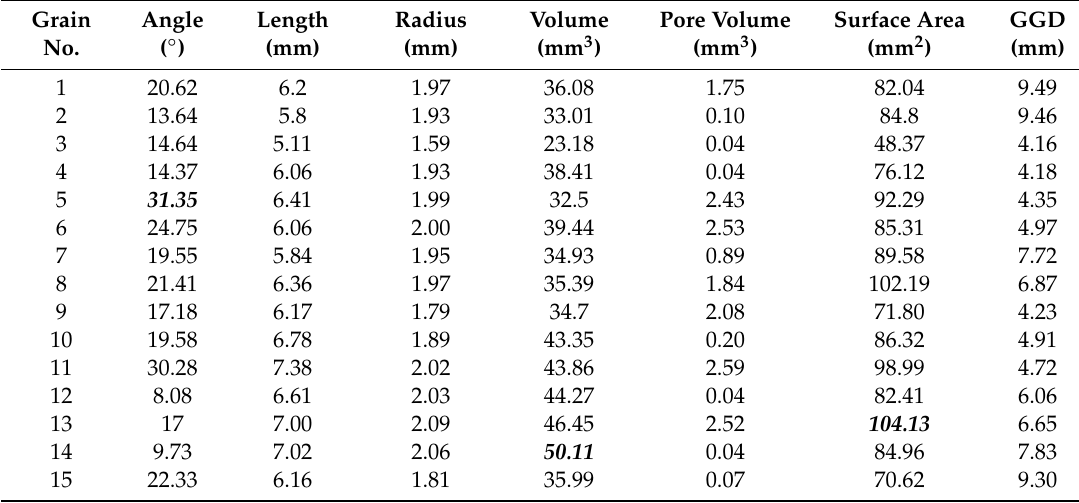
Figure 22. The detected grains for wheat spike No. 1170. The grain number is sorted with their gravity height in descending order. We can see that No. 5 grain has bigger angle, No. 11-14 grains have bigger volume and No. 13 grain has biggest surface area. Table 3. The phenotypic information of grains in spike treatment No.